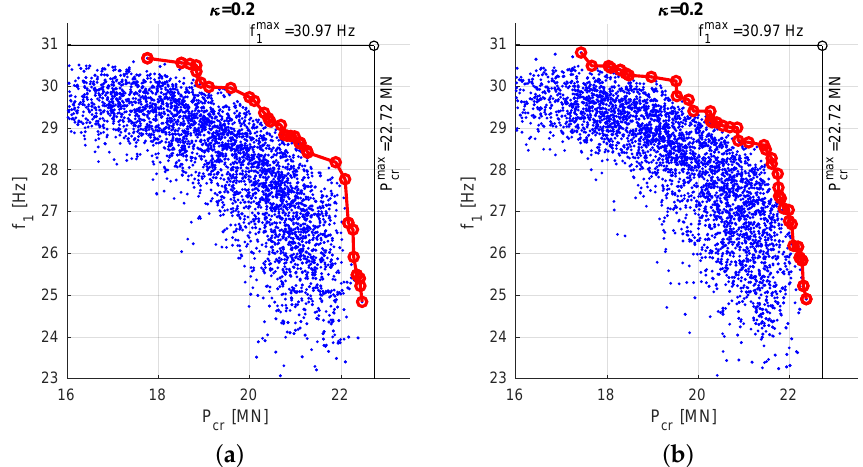
Figure 8. Pareto front obtained through MOO procedure: ( a ) f 0 = f max = 30.97 Hz; P 0 ( b ) f 0 1 1